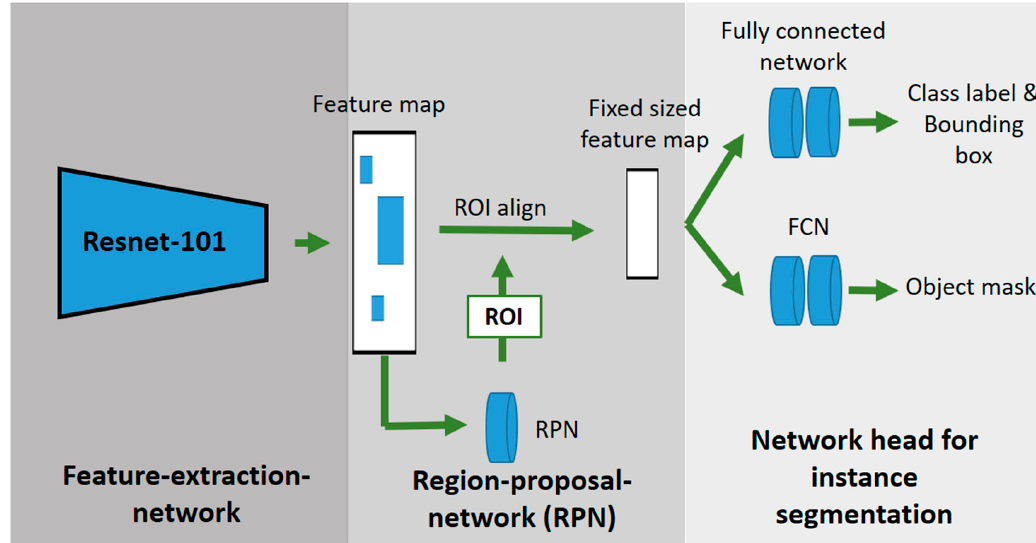
Figure 4 . Schematic structure of a Mask-R-CNN-based on He et al. [31] Figure 4. Schematic structure of a Mask-R-CNN-based on He et al. [31]. To evaluate the detection and segmentation results, the mean average precision (mAP) of the individual classes was calculated. The calculation of the mAP consists of the Precision calculation of the precision (Equation (3)), the recall (Equation (4)), and the intersection over union (IoU). The precision describes how many of the detected pixels were correctly classified as the ratio between true positives (TP) and false positives (FP). The recall cal- culation shows the ratio of all correctly segmented pixels (TP) to the missed pixels (False Negative—FN). The IoU is the ratio between the common overlap of the ground-truth segmentation and the generated segmentation to the total segmented area. After the pre- cision and recall metrics have been calculated, the recall values are plotted on the x-axis and the precision values are plotted on the y-axis. The mAP is then determined by the area under the resulting precision and recall curve. For the final calculation of the mAP, the intersection over union (IoU) threshold for a TP is increased step by step from 0.5 to 0.95. The resulting values are averaged to a final mAP value [44].